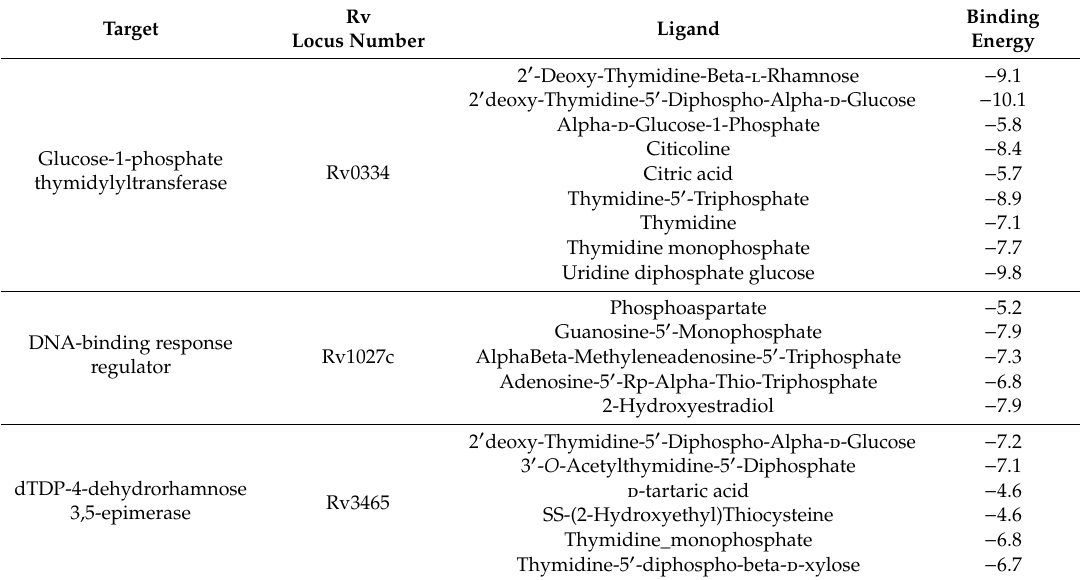
Table 2. The Autodock vina score of all drug targets with their ligands from the DrugBank database. The binding energies are indicated by a bold black color in the case of top